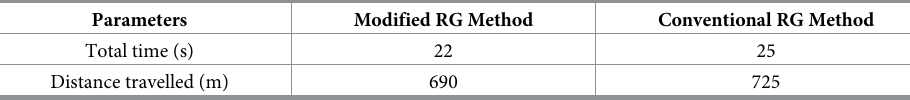
Table 6. Comparison of time and distance in scenario